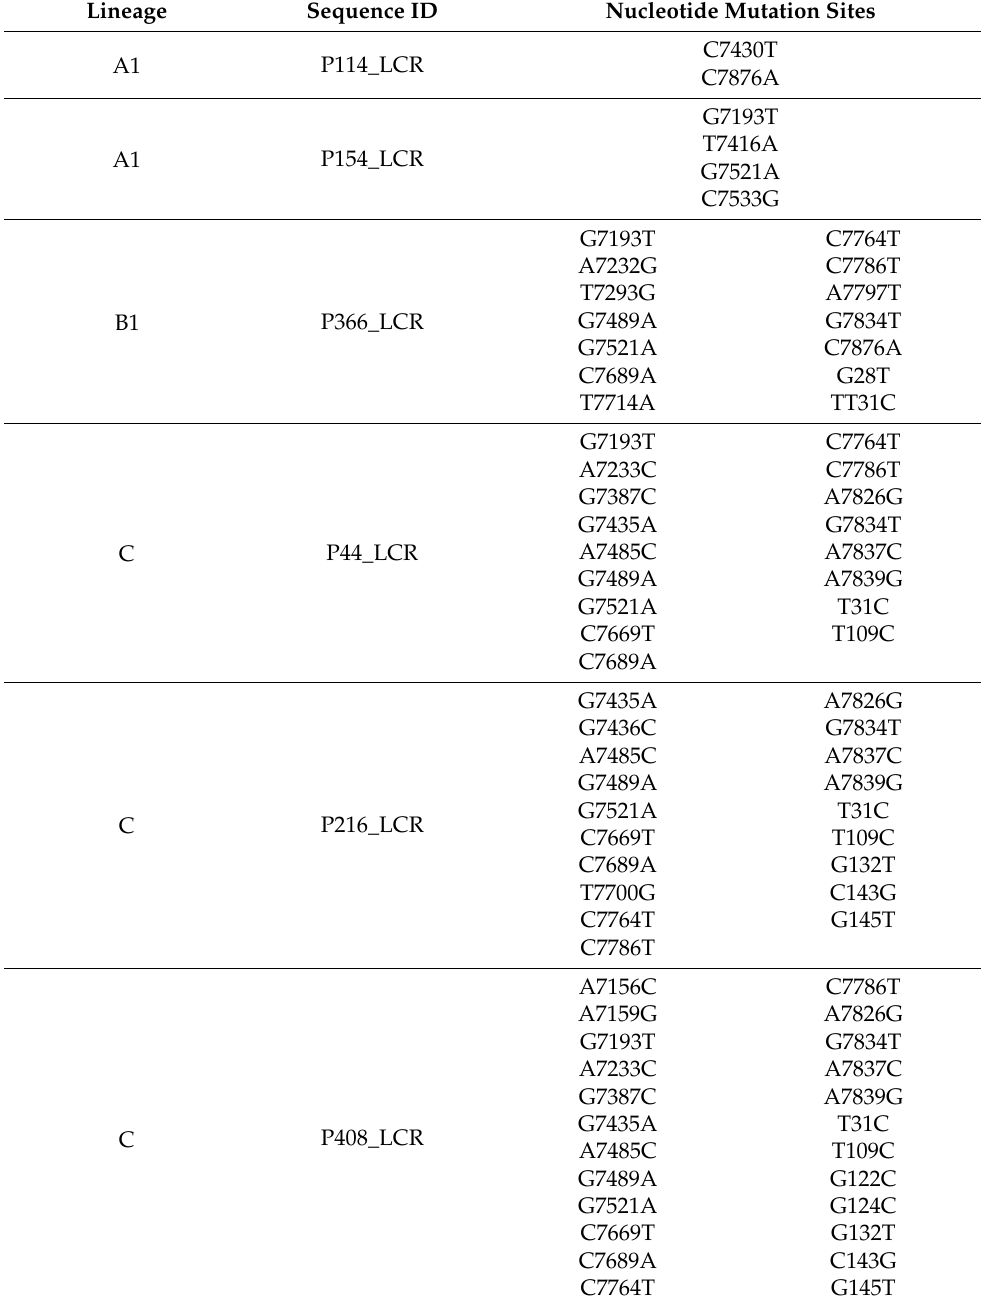
Table 3. LCR * nucleotide mutations by position and samples from Kinshasa